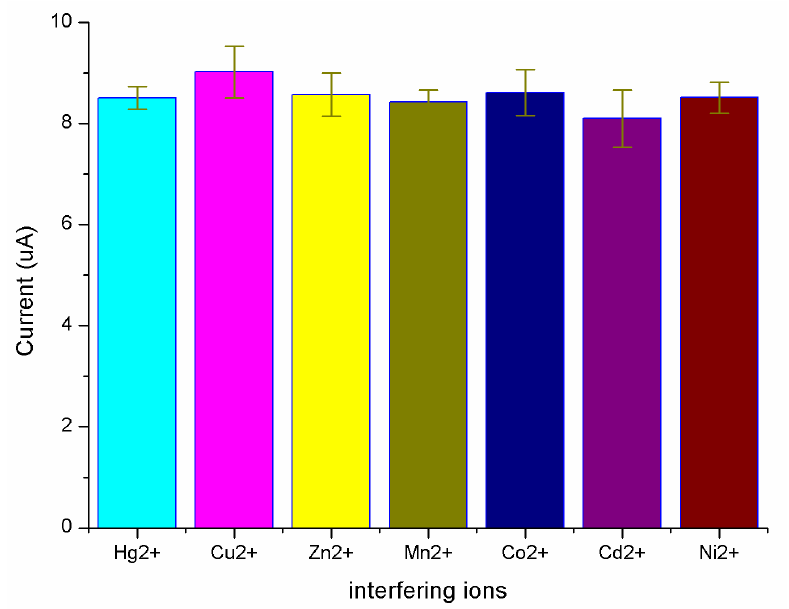
Figure 6. Current peak in the presence of 50 ppb marked metal ions followed by addition of 5 ppb Hg 2 + with the blank solution